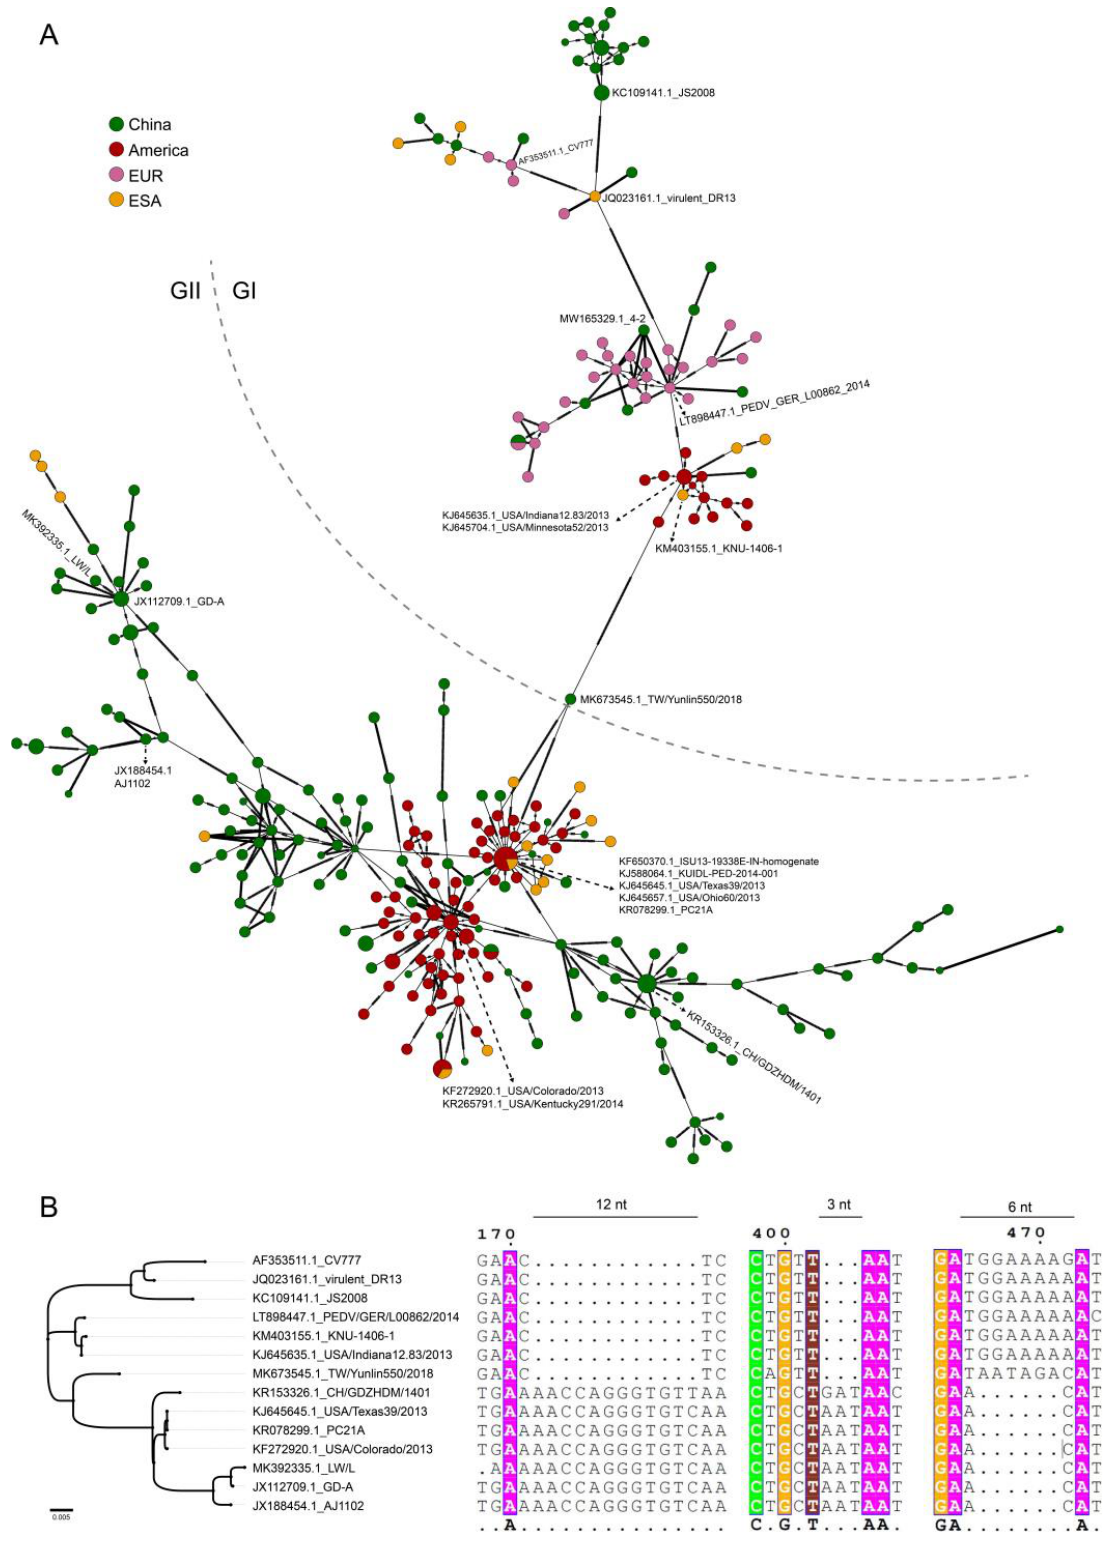
Figure 4. Haplotype analysis of PEDV S gene: ( A ) the haplotype networks of PEDV based on the S gene; different colors represent viruses in different regions; green represents China, red represents the Americas, pink represents Europe (EUR), yellow represents East Asia (except China) and South Asia (ESA); ( B ) evolution of the PEDV based on the representative strains from dominant haplotype; ‘.’ represents the nucleotide sequence with the gap. 4. Discussion The S protein of coronavirus directly interacts with cellular receptors; the diversity of the S gene is often used as the phylogenetic marker in evolutionary analysis. The com- plete genomes of diverse strains from the global database promotes a better